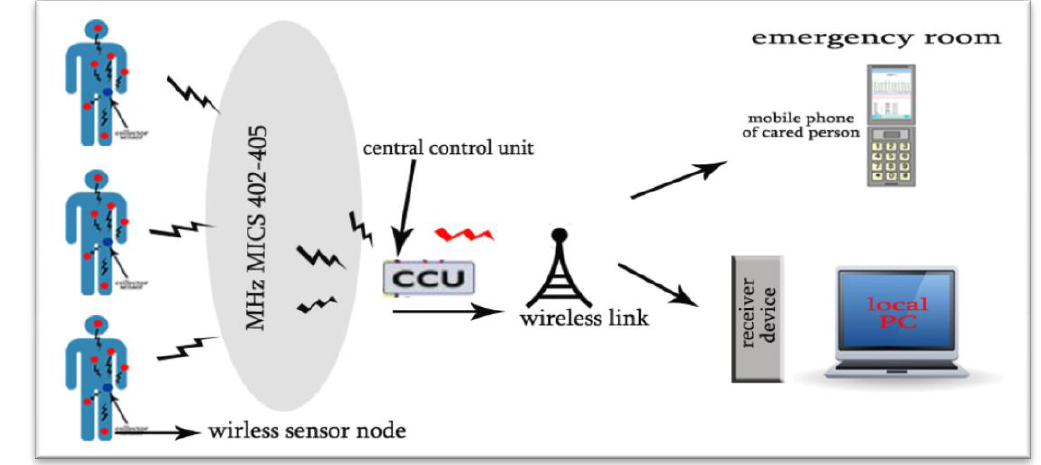
Figure 1. The architecture of wireless body area